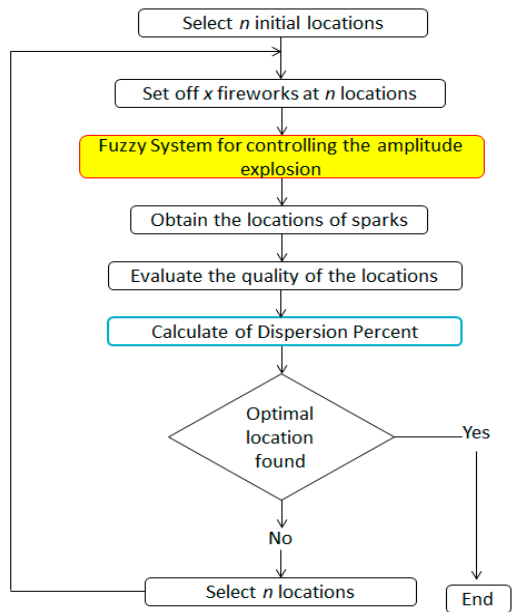
Figure 2. Flow chart of Dispersion Percent Iterative Fireworks Algorithm (DPIFFWA).